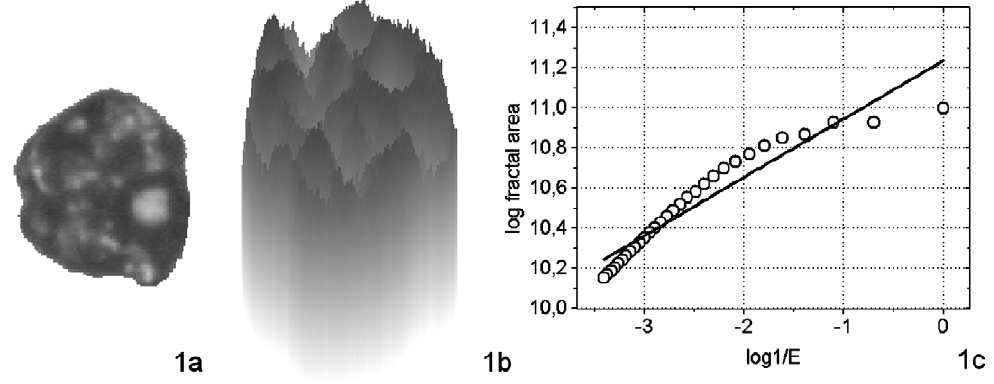
Fig. 1. Leukemic blast (a). Accentuated coarseness of the surface in the pseudo-3D representation of the chromatin (b) and concavity of the regression line in the log–log-plot ( R 2 = 0 . 904; (c)).